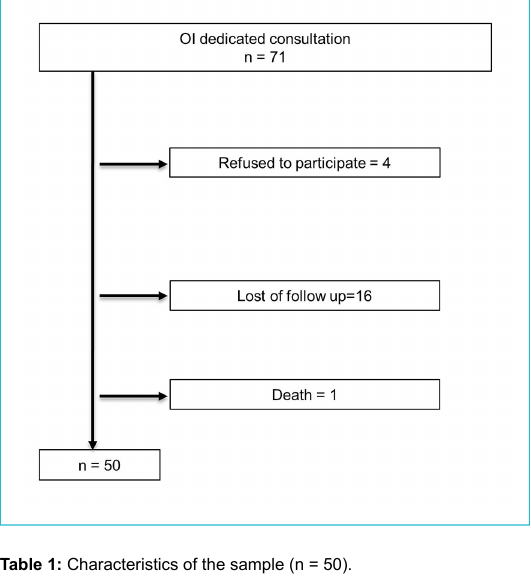
Figure 3: Patients excluded . OI = osteogenesis imperfecta